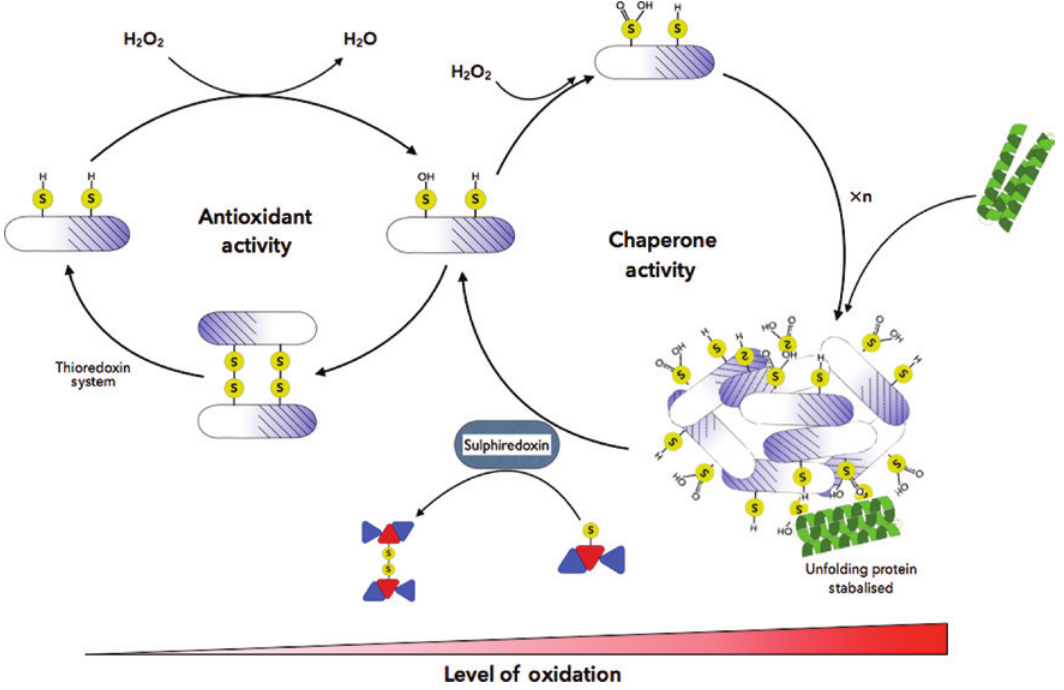
Figure 4: The redox nano-switch of ‘typical’ 2-Cys peroxiredoxin. The antioxidant activity of T2 CP is considered to predominate when levels of ROS are low. However, an increase in cellular stress creates HMW structures, where T2 CP switches its role from antioxidant to chaperone, stabilizing unfolded proteins. This switch is believed to be regulated through overoxidation to sulphinic acid, which can be reversed by sulphiredoxin, regenerating reduced T2